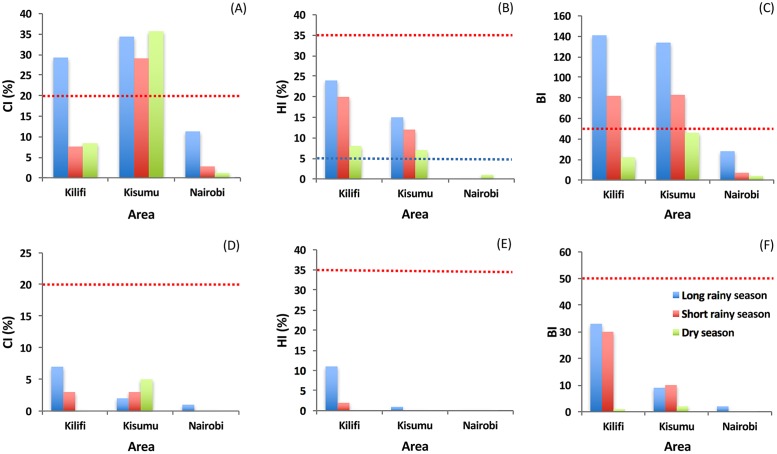
Seasonal risk levels of Aedes aegypti and Aedes bromeliae in Kilifi, Kisumu, and Nairobi Counties in Kenya.(A) Container Index (CI), (B) House Index (HI), (C) Breteau Index (BI) for Aedes aegypti; (D) Container Index (CI), (E) House Index (HI and (F) Breteau Index (BI) for Aedes bromeliae. Blue dashed line represents the DEN epidemic threshold level as defined by PAHO [51]. Red dashed line represents the YF epidemic threshold levels according to WHO [50].